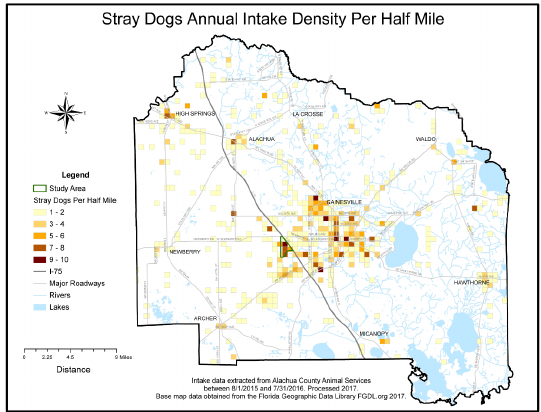
Figure 3. Stray Dog Annual Intake Density